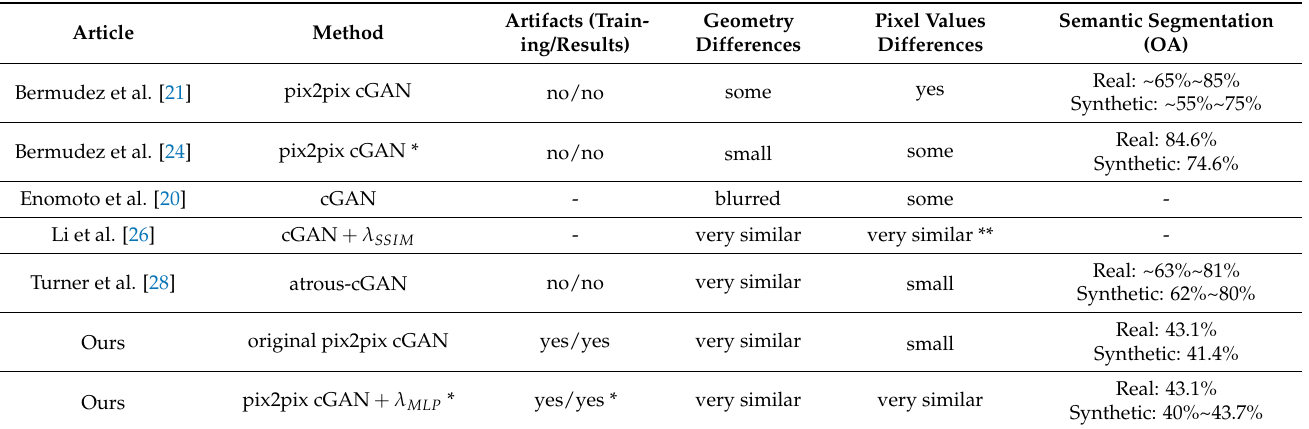
Table 7. Comparison of obtained results in earlier studies, with the baseline original pix2pix cGAN and the proposed approach for the generation optical satellite images using